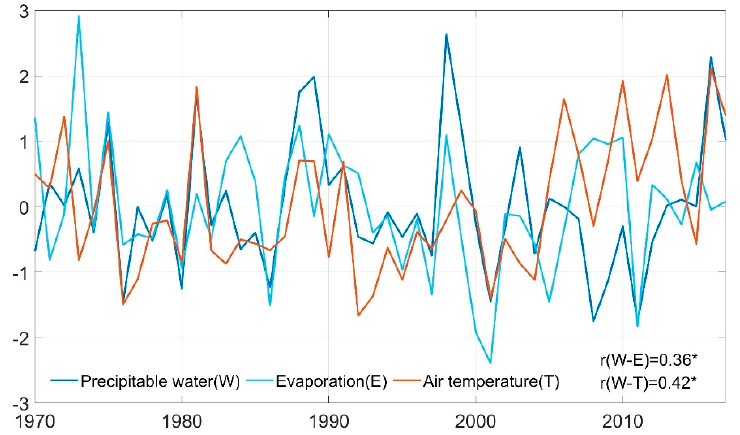
Figure 8. The standardized anomaly of precipitation water, evaporation, and air temperature in SAIE from 1970 to 2017.